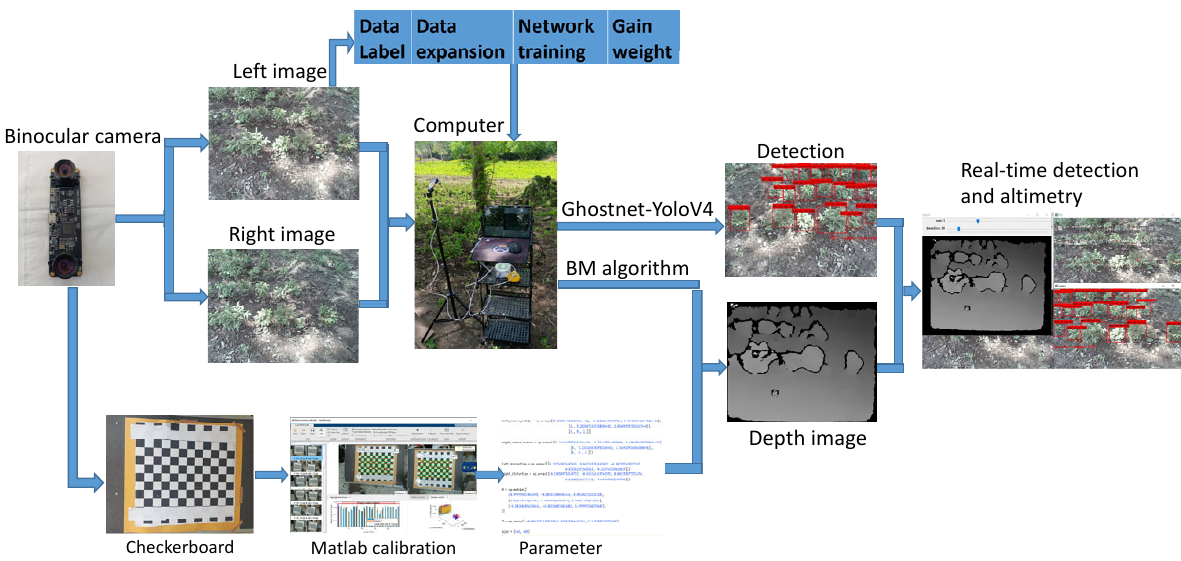
Figure 1. Detection process of tree saplings collected in the field environment.